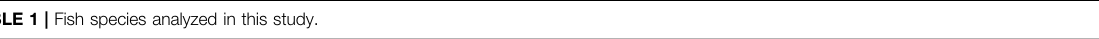
TABLE 1 | Fish species analyzed in this